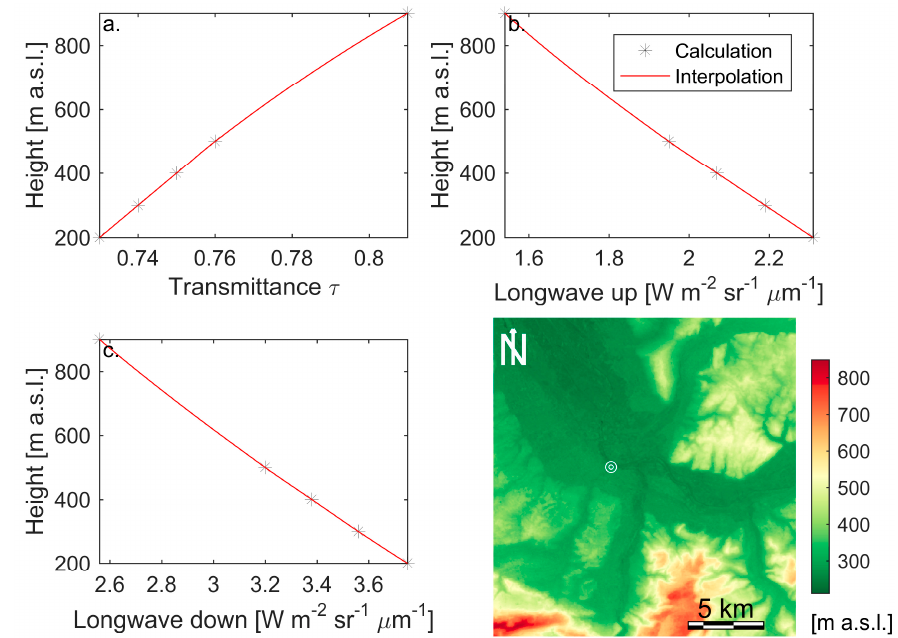
Figure 3. Atmospheric correction parameters: ( a ) transmittance; ( b ) longwave upward radiance and ( c ) longwave downward radiance, exemplary of 30 August 2015 according to the different path lengths or the different height a.s.l. of the individual pixels. The asterisk represents the calculated value and the red line the interpolated values. The colored map describes the topography of the investigation area with the city center of Basel as a white circle.